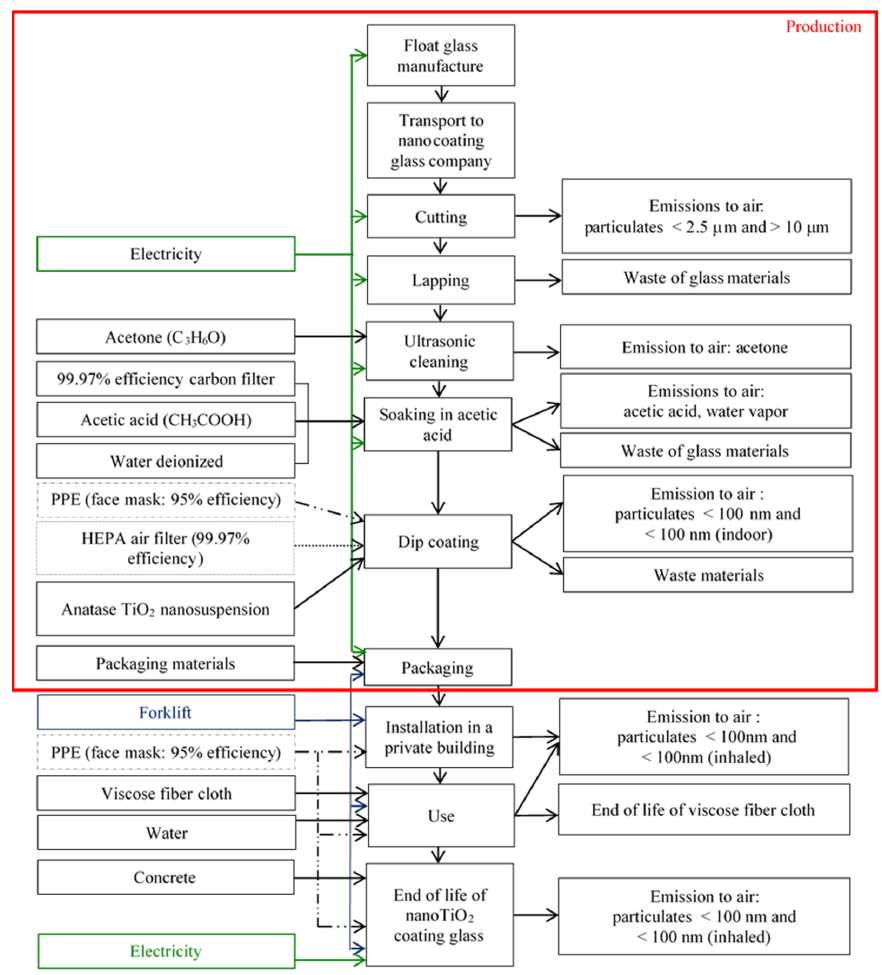
Figure 1. Flow chart of nanoTiO 2 (titanium dioxide) self ‐ cleaning coated float glass.